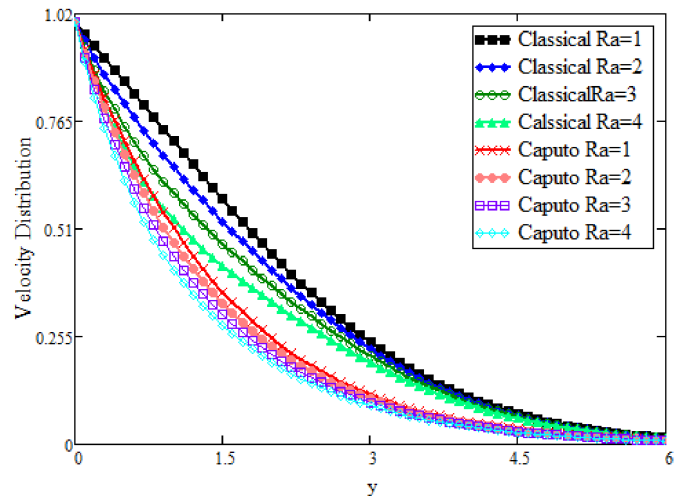
Figure 3. Comparative analysis of velocity distribution for different Ra values.